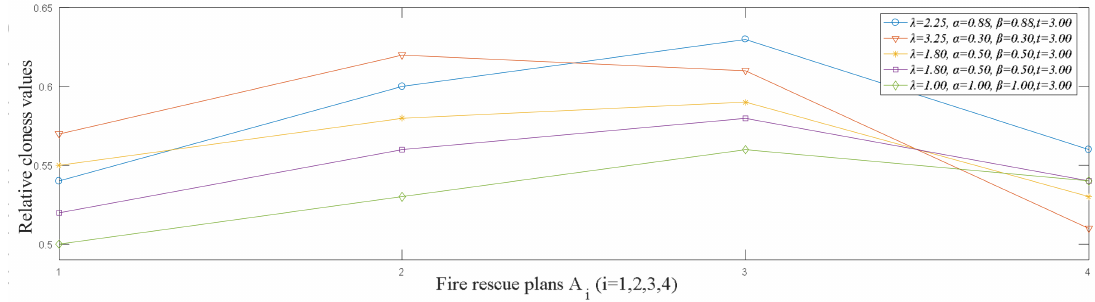
Figure 4. The ranking results obtained by different risk preference